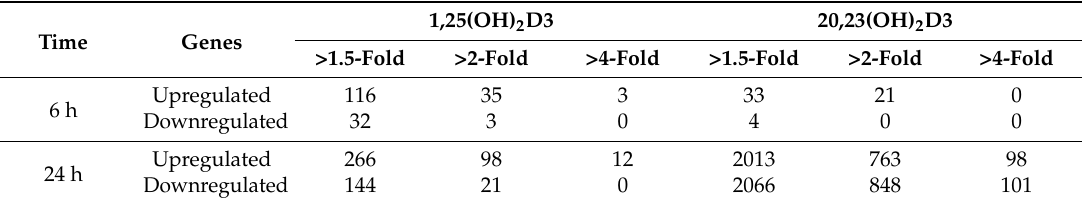
Table 1. Number of genes up or downregulated in keratinocytes by 1,25(OH) 2 D3 or 20,23(OH) 2 D3 in comparison to vehicle control using 1.5-, 2- and 4-fold cut-off